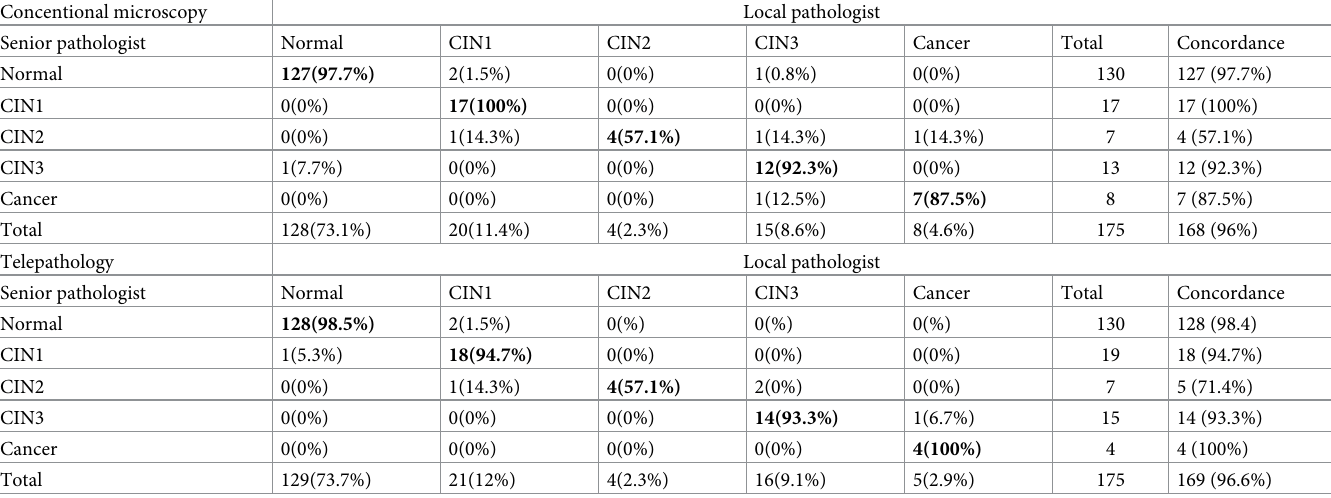
Table 2. Agreement between senior and local pathologists for diagnoses established on conventional microscopy and